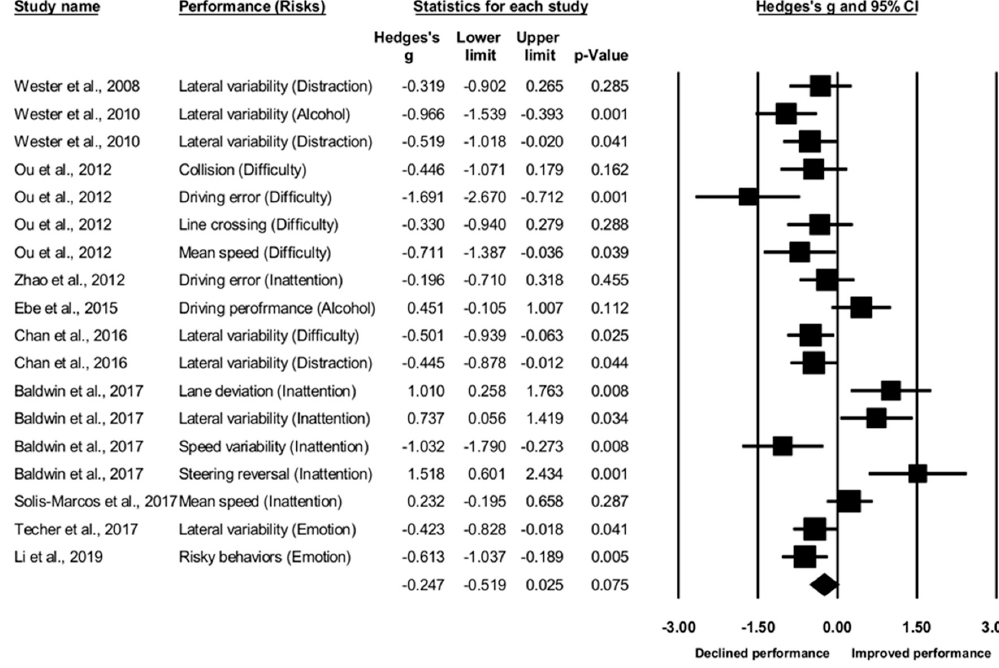
Figure 2. Forest plot for driving performance in relation to the risk factors.